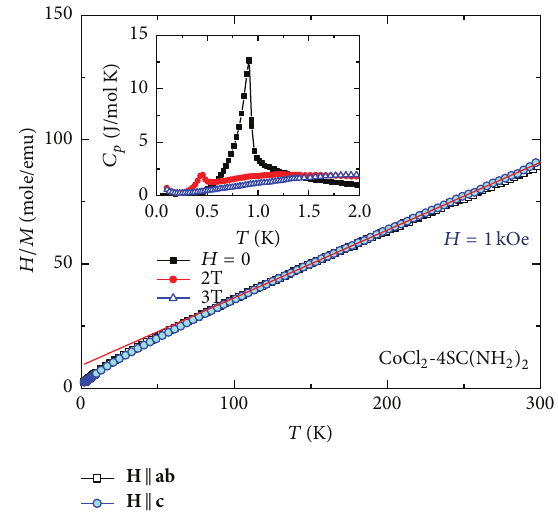
Figure 2: Inverse magnetic susceptibility, 𝐻/𝑀(𝑇) , of CoCl 2 - 4SC(NH 2 ) 2 as a function of temperature for magnetic fields H of 1kOe applied ‖ ab and ‖ c . Solid lines represent a Curie-Weiss fit. Inset shows specific heat data at selected magnetic fields for H ‖ c